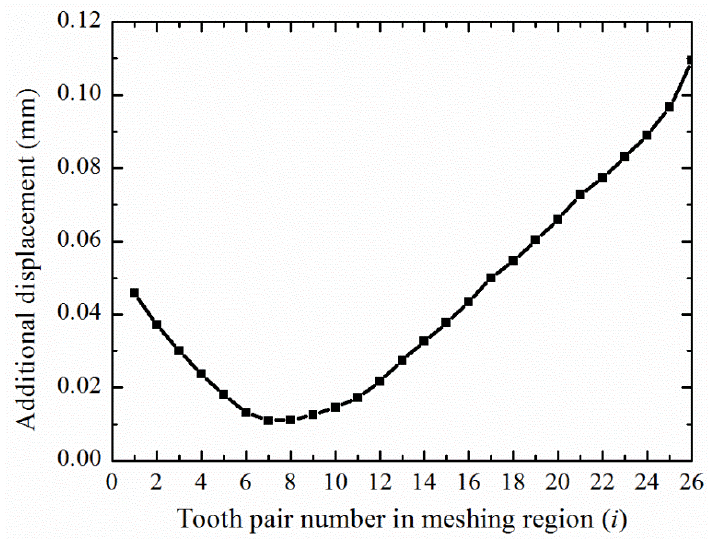
Figure 15. Additional tangential displacement of flexible wheel teeth in the meshing region. With the continuous meshing of subsequent gear teeth, the deformation of flexible teeth in the meshing region decreases slowly and then increases gradually. After consider- ing the additional displacement, the modified disposable harmonic gear meshing stiffness is shown in Figure 16.